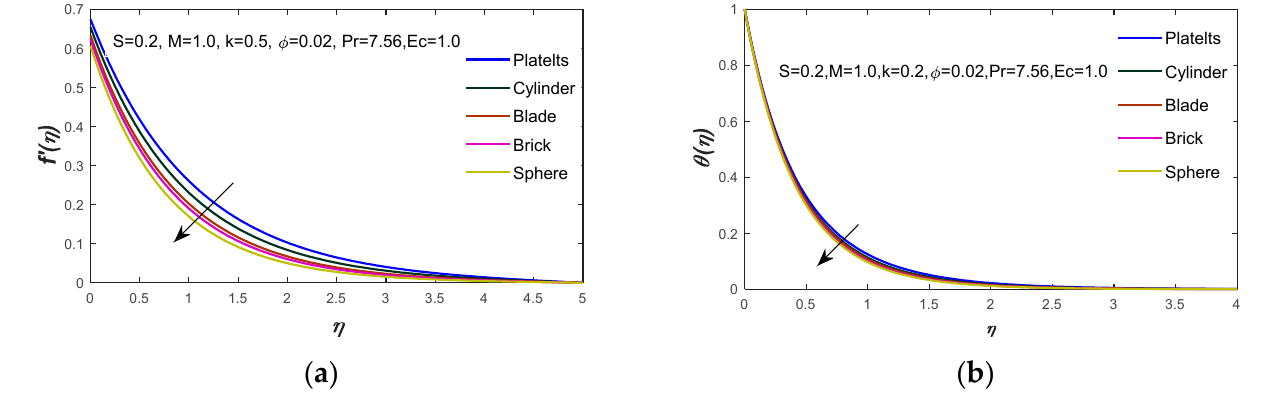
Figure 10. ( a – e ). Impact of 𝑃𝑟 on 𝜃(𝜂) by using various shapes factors of nanoparticles for fixed 𝑀 = 1.0, 𝑃𝑟 = 6.0, 𝑆 = 0.5, 𝑘 = 0.5, 𝜑 = 0.02 .